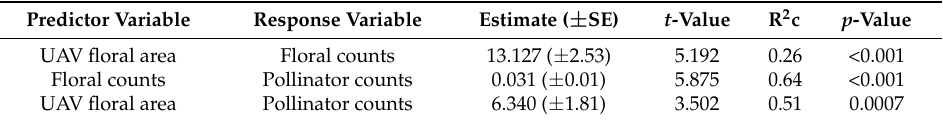
Table 2. Results from fitting linear mixed-effects models using the unmanned aerial vehicle (UAV)-estimated floral area within a quadrat to predict visual estimates of floral counts. UAV-estimated floral area and floral counts were used to explain pollinator visits, and natural enemies observed within quadrats. Response variables were natural logarithm-transformed prior to analysis. Natural enemy diversity was estimated using the Shannon index (H). R 2 c represents the conditional R 2 , which describes the proportion of variance explained by the fixed and random factors of the regression with df = 95 for each